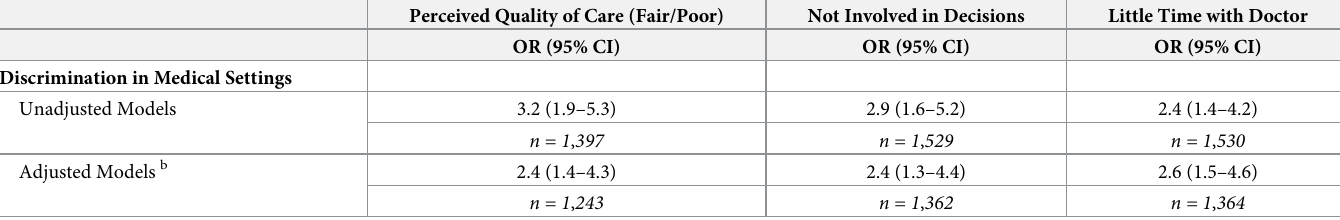
Table 3. Unadjusted and adjusted odd ratios for the association of perceived discrimination in medical settings with three health care quality outcomes a